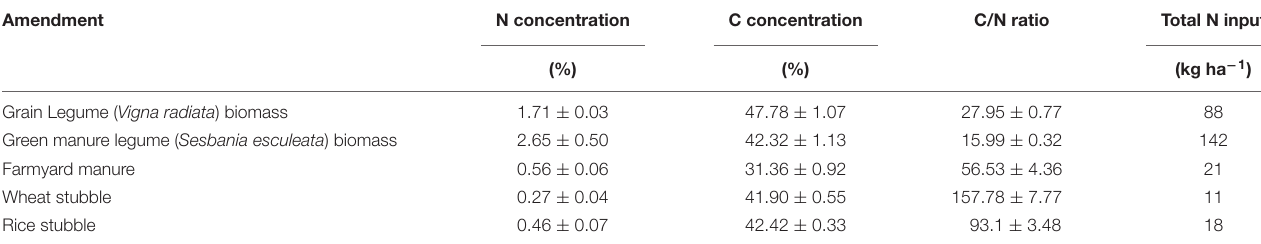
TABLE 3 | Total dry matter and total nitrogen (N) inputs through organic sources used under different management during the preceding rice season.